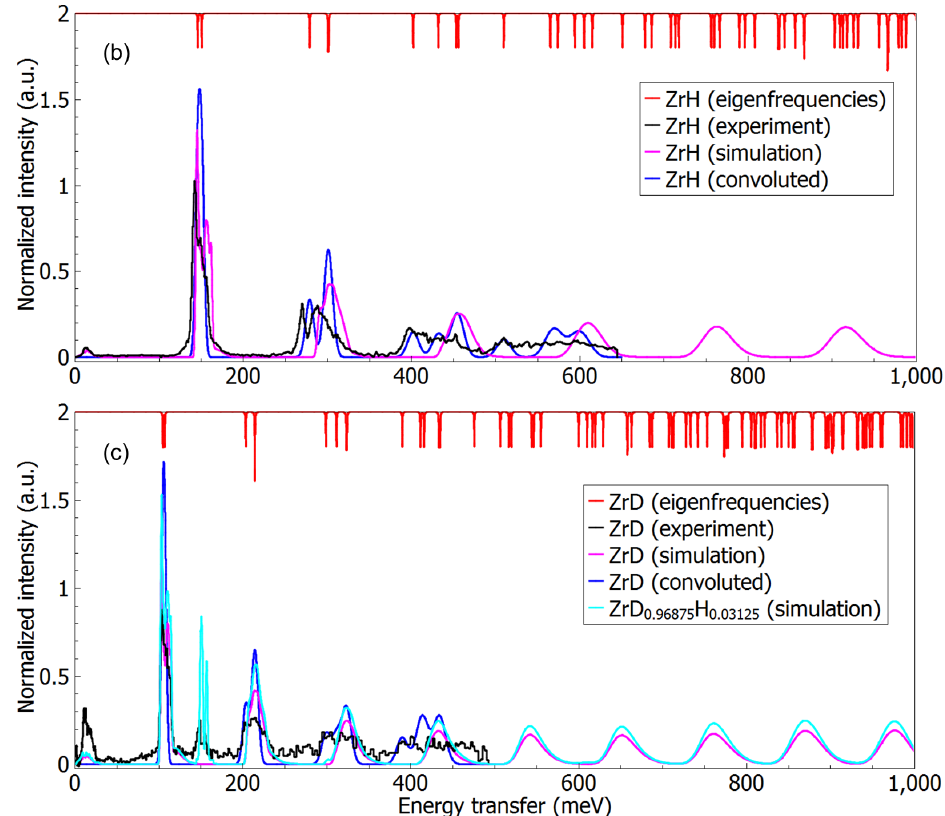
Figure 8. The INS spectra for ( a ) (cid:101) -ZrH 2 , ( b ) γ -ZrH, and ( c ) γ -ZrD. Eigenfrequencies from the Schrödinger equation are in red lines, the experimental INS spectra are in black lines, the INS spectra simulated in the harmonic approximation are in magenta lines, blue lines represent the spectra of eigenfrequencies convoluted with spectrometer resolution functions, and cyan lines in ( c ) are the simulated spectrum of contaminated γ -ZrD. Spectra were normalized with respect to their area under the fundamental spectra curve. A convolution procedure was applied up to the third overtones. The ratio of the neutron scattering cross-section of H and D is 82.02/7.64 = 10.74, and m ( D ) / m ( H ) = 2, therefore the fundamental mode intensity ratio of 1% H to 99% D should be ∼ 10.74 × 2 × 0.01/0.99 = 0.22 (without corrections for the Debye–Waller